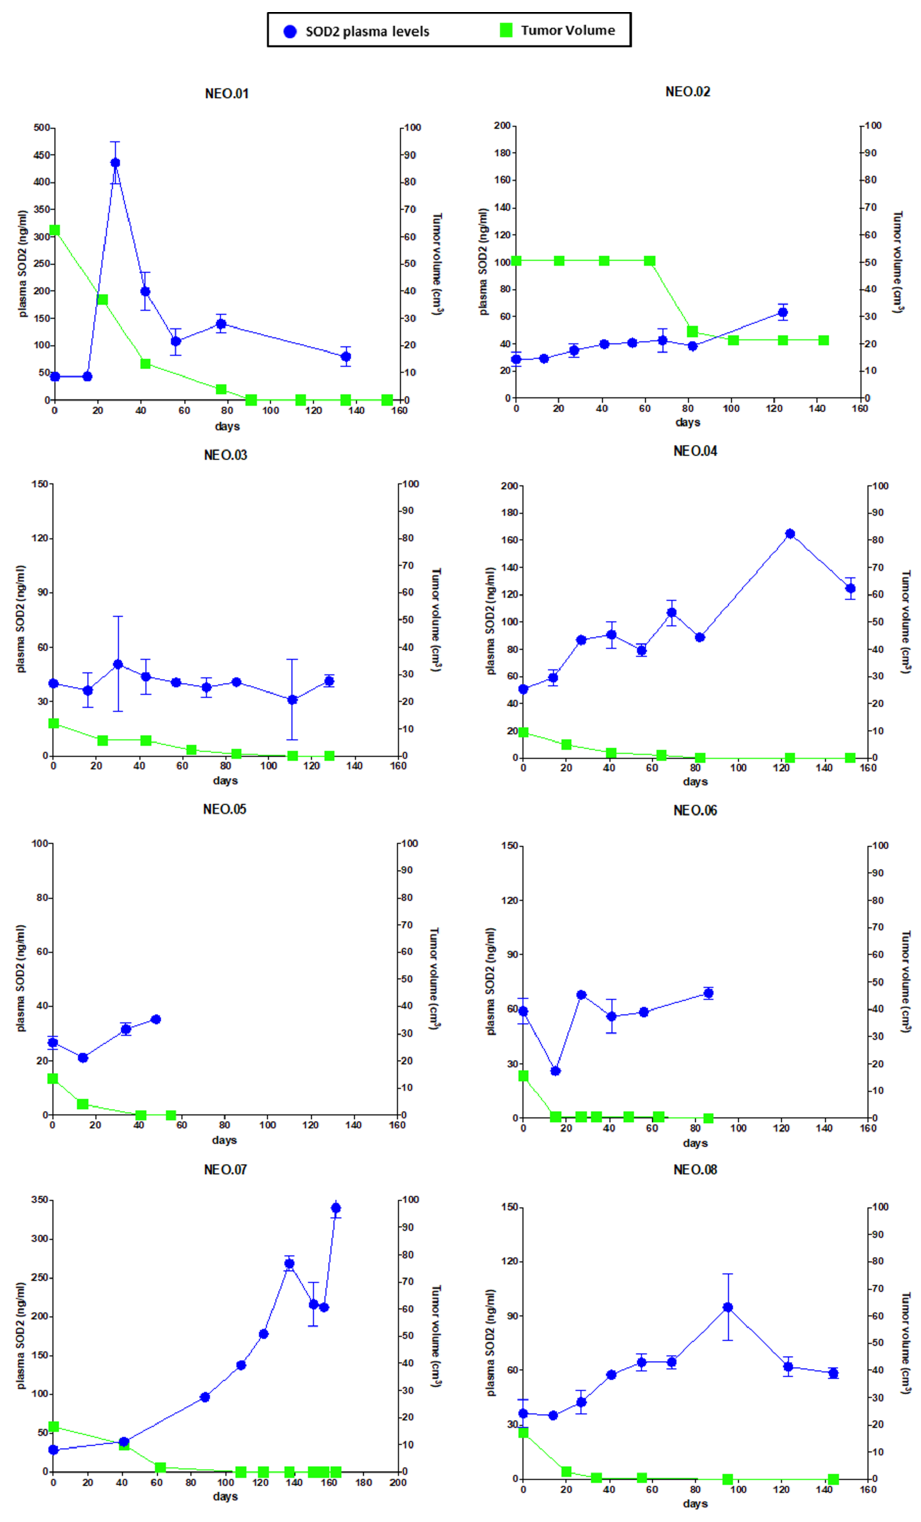
Figure 5. SOD2 levels in the plasma of BrCa patients correlate with their response to neoadjuvant chemotherapy. Plot showing SOD2 plasma levels and tumor volume over the time of neoadjuvant treatment. Tumor volumes (cm 3 ) were assessed clinically by caliper measurement, and SOD2 levels were evaluated in triplicate by ELISA in plasma from 8 BrCa patients. Error bars correspond to the standard deviation from the mean of the triplicate